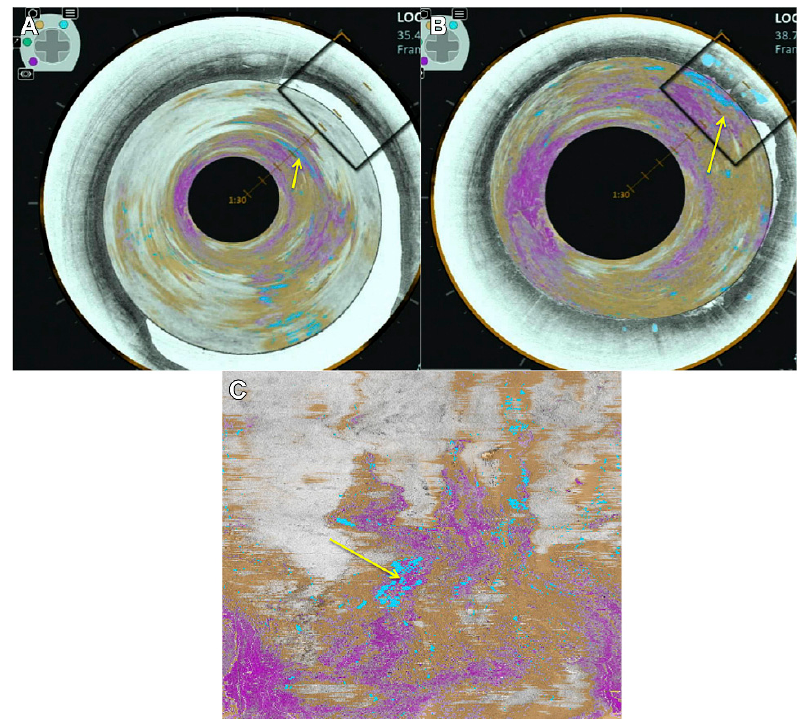
Figure 3. Volumetric laser endomicroscopy (VLE) of the esophagus showing a luminal en face view of an area of overlap (yellow arrow) between the 3 features of dysplasia (orange is lack of layering, blue is glandular structures and pink is a hyper-reflective surface). ( A ) A view looking down from the proximal esophagus. ( B ) A view closer to the suspected area of dysplasia. The en face view is also shown ( C ). Figure and caption adapted from Trindade et al. 2019.